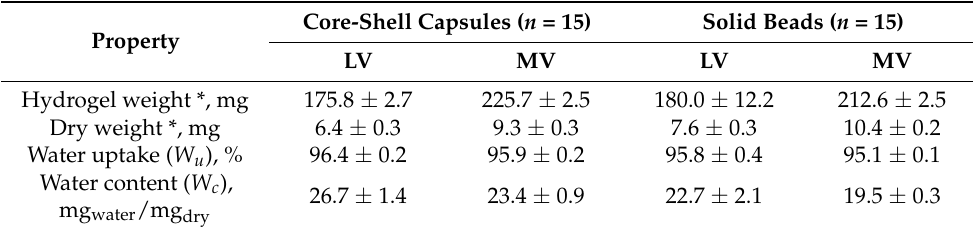
Table 1. The results on analysing the water uptake and content of fifteen core-shell capsules and solid